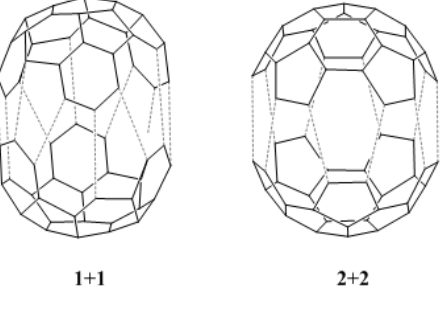
Figure 4. Dimerization reaction between two fragments of type 1 ( 1 + 1 ), and between two fragments of type 2 ( 2 + 2 ).